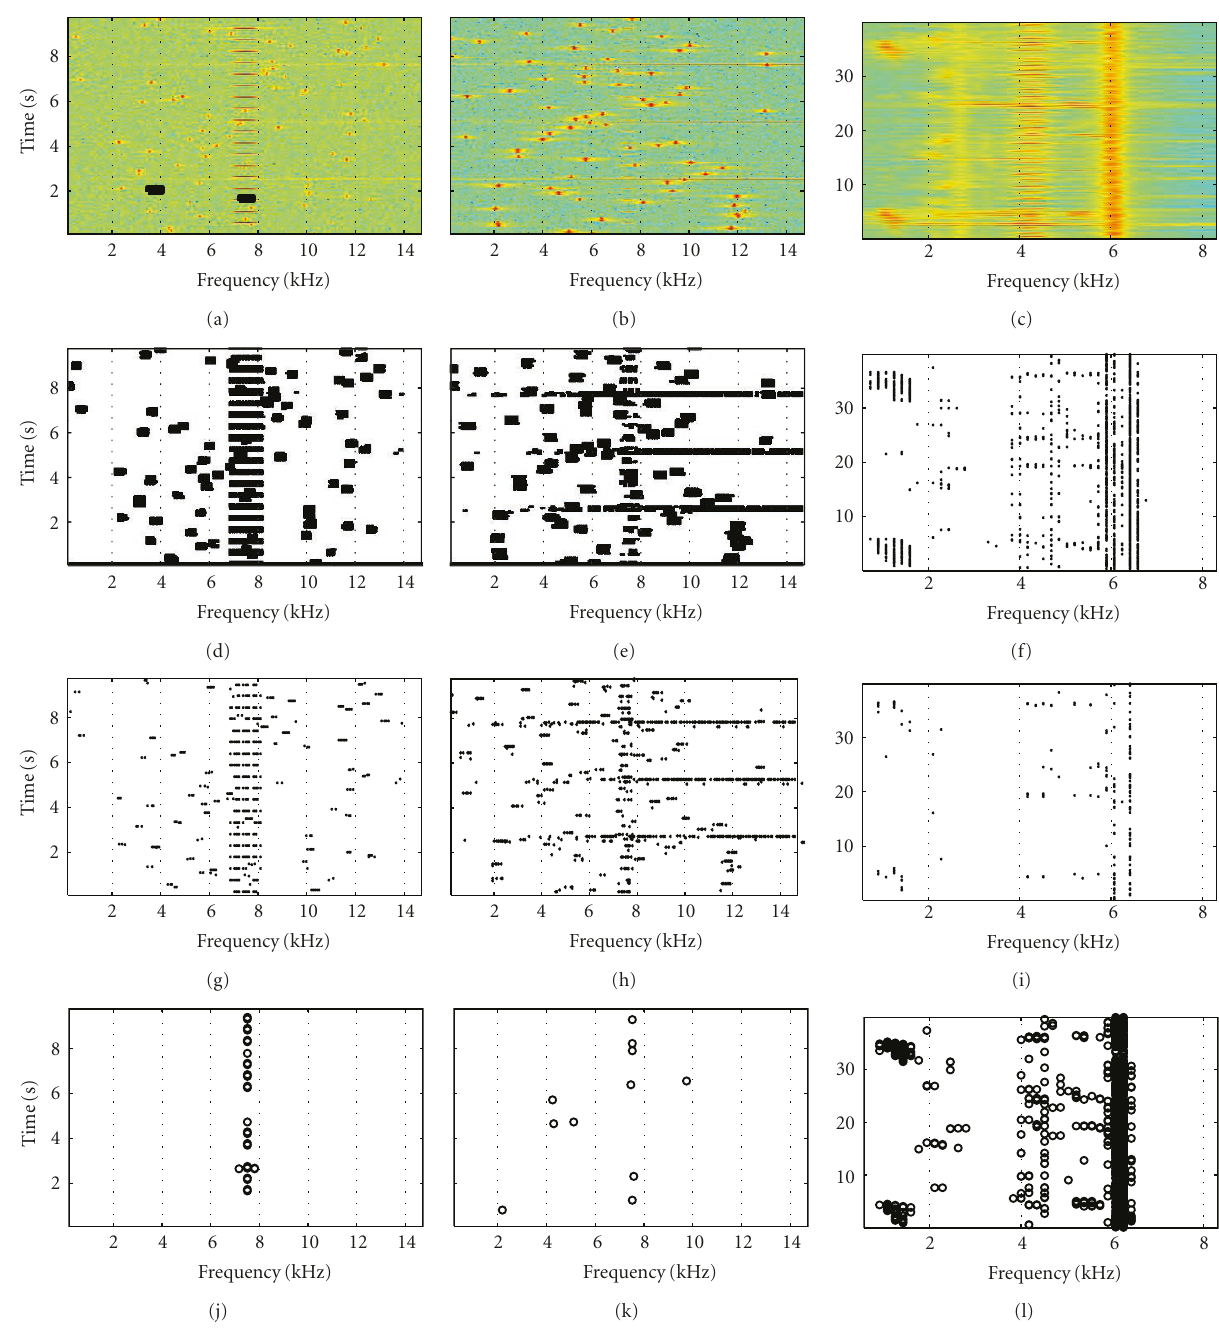
Figure 5: The rows from top to bottom: spectrogram, the first primary mask, the second primary mask, and the secondary mask for experiments given by columns from left to right: one (weak NB interfering signal), two (strong NB interfering signal), and three (bird call).